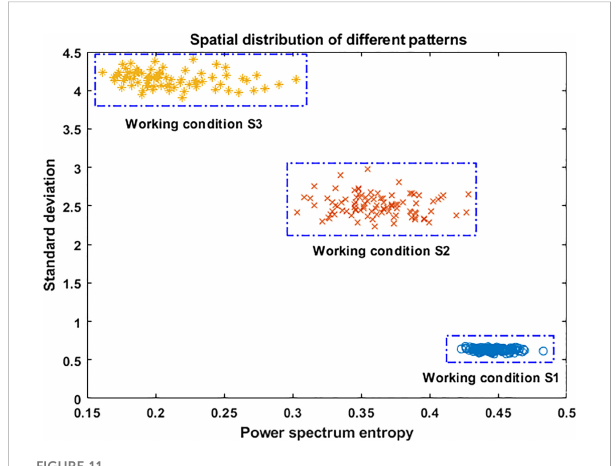
FIGURE 11 Distribution of the SD and the PSE coordinates.